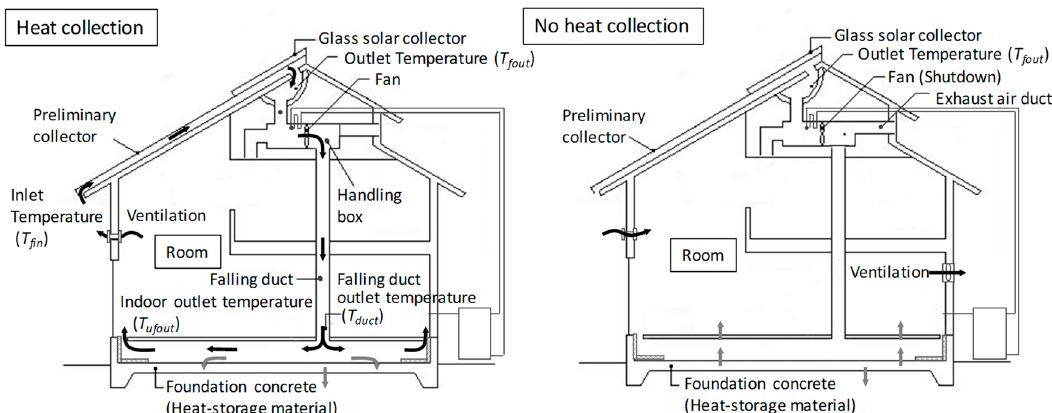
Figure 9. Operation control of air-based solar heat collection system.